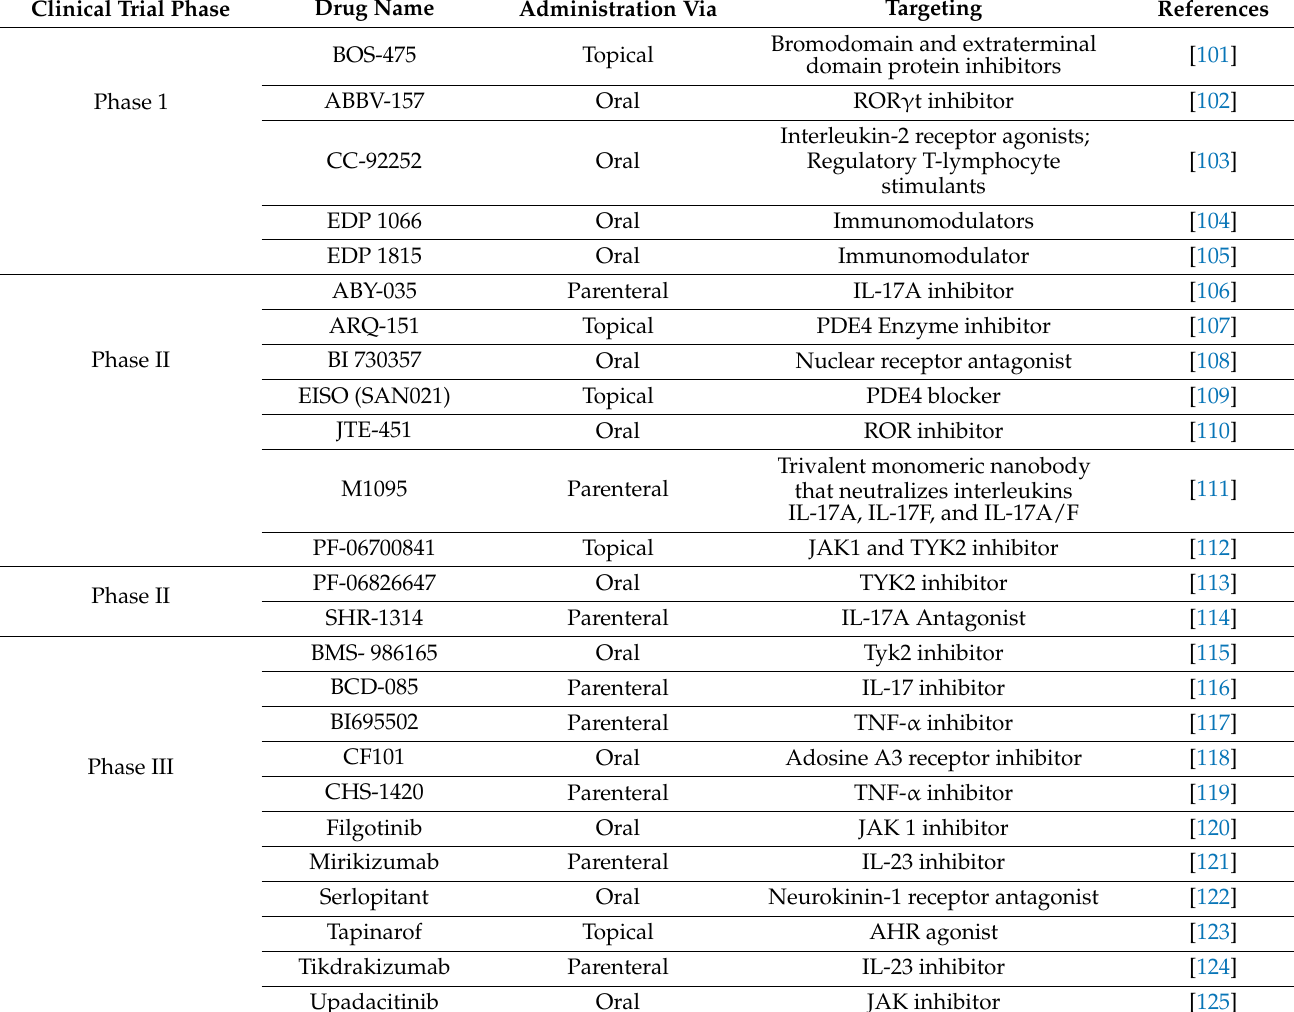
Table 3. Cutting edge treatments for psoriasis under clinical